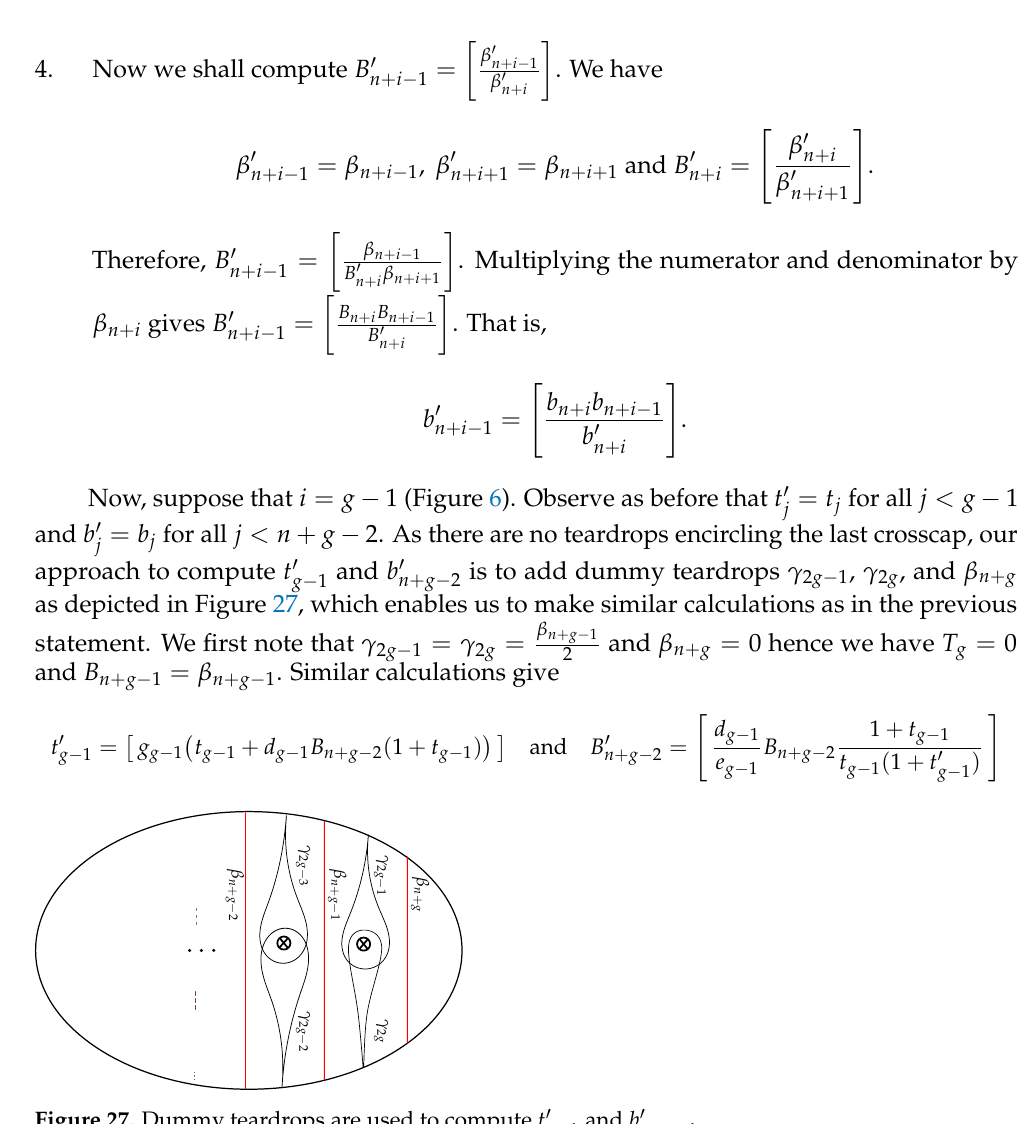
Figure 27. Dummy teardrops are used to compute t (cid:48)